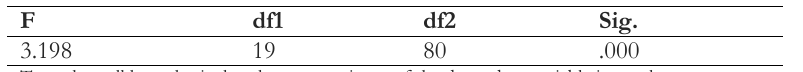
Table 8. Levene's test of equality of error variances a : dependent variable - moisture absorption.